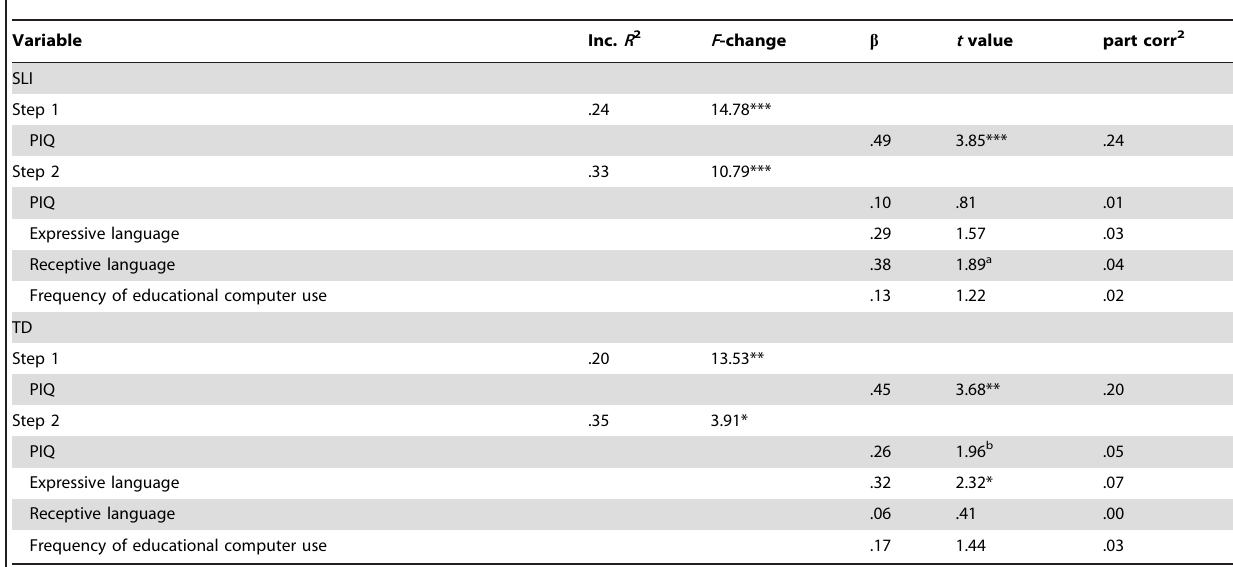
Table 4. Hierarchical regression analysis predicting GCSE core subject score separately for young people with SLI and TD peers continuing in post-compulsory